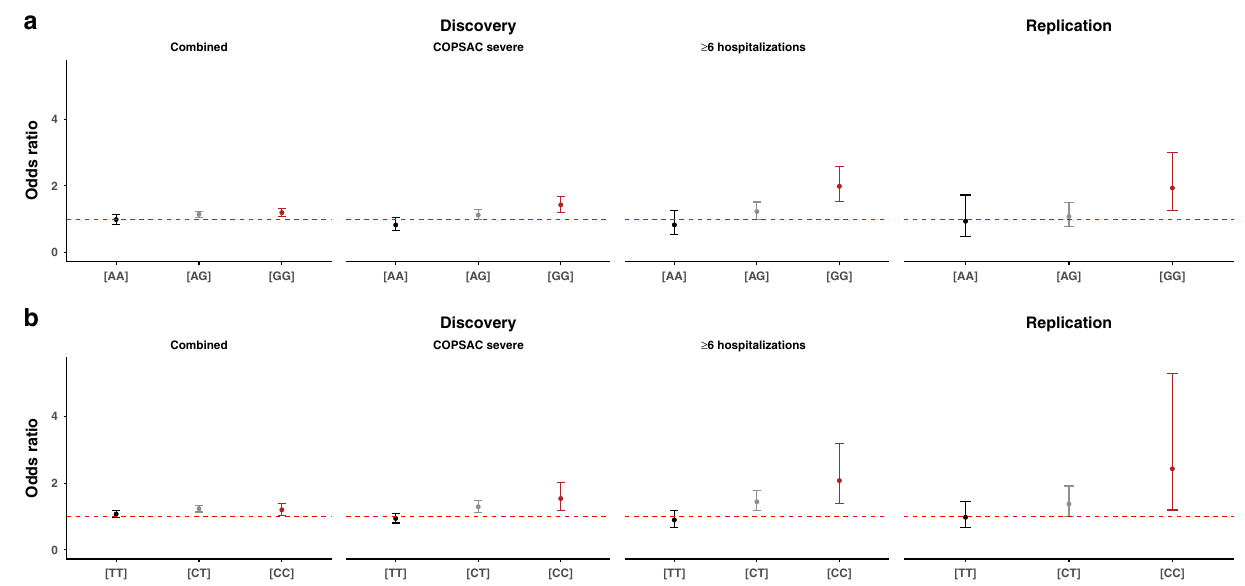
Fig. 3 Strati fi ed FUT2 (rs601338) and ABO (rs505922) effects in the discovery and replication stages. For the discovery stage, the effects are shown in strata with increasing phenotype severity, namely the overall strati fi ed results (iPSYCH + COPSAC severe ), COPSAC severe , and the cases with six or more hospitalizations from COPSAC severe . a illustrates the ABO effect strati fi ed on the FUT2 genotypes (AA, AG, and GG). b illustrates the FUT2 effect strati fi ed on the ABO genotypes (TT, CT, and CC). For the discovery analyses, the strati fi ed logistic regression model is adjusted for ten principal components and sex. Replication analyses are adjusted for sex and cohort status. Coloring of the error bars represents the different genotype groups. Error bars represent the 95% con fi dence interval for each strati fi ed estimate. The estimate is represented by the circles. N combined = 68,281 ( N cases = 2866, N controls = 65415). N COPSAC severe = 6532 ( N = 1204, N = 5328), N ≥ 6 = 5707 ( N = 379, N = 5328). N = 918 ( N = 191, N = 727). cases controls hospitalizations cases controls replication cases controls